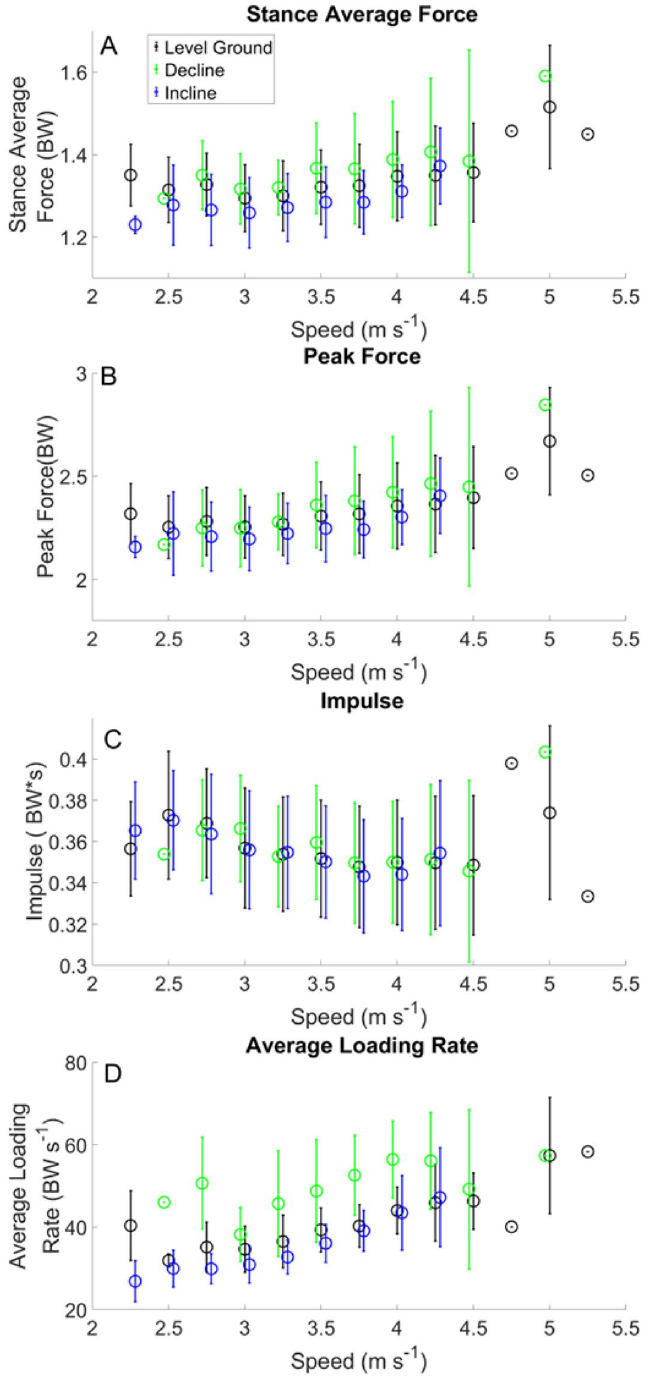
Figure 5. Kinetic variables across the range of running velocities and